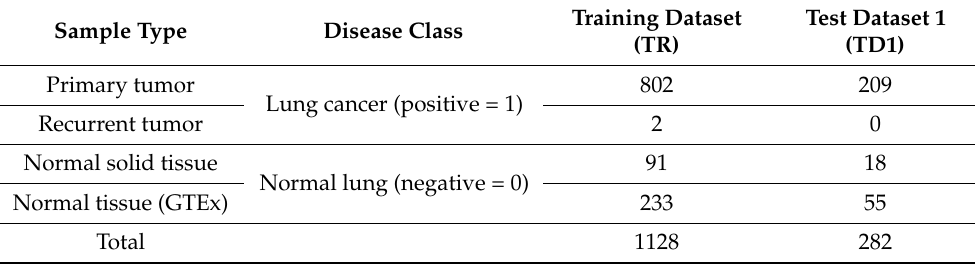
Table 1. The number of TCGA and GTEx lung samples used for DEGs analysis and development of the LASSO logistic regression